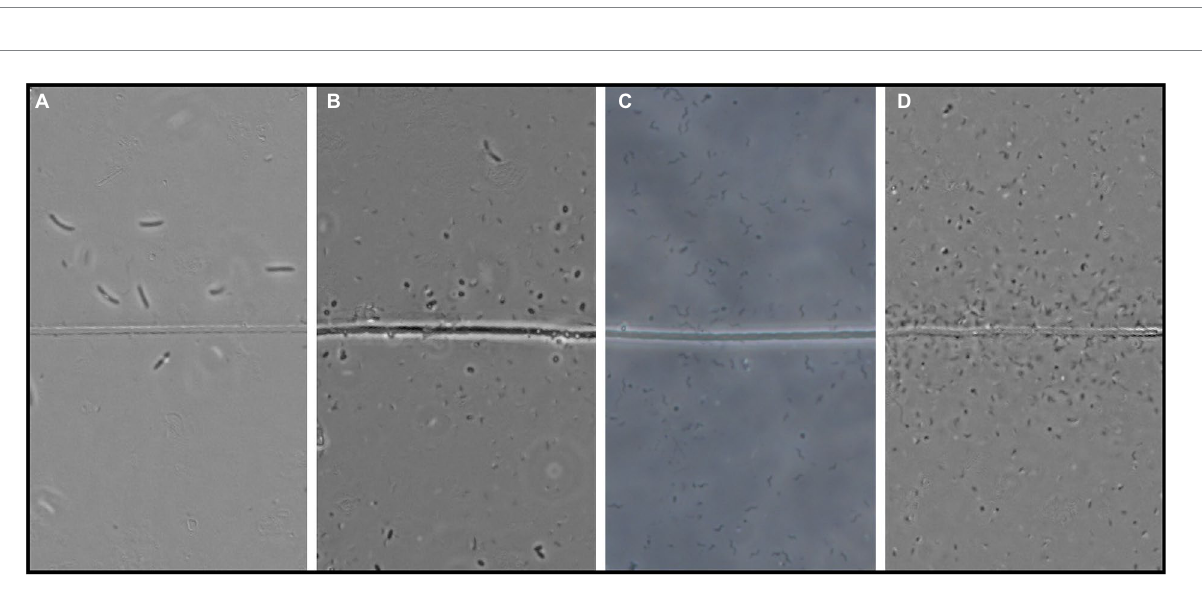
FIGURE 3 Four examples of the observed flocker morphologies. (A) Large curved rods, (B) Coccoids, (C) Spirillae, and (D) Vibrioids. “Line” in the middle is the cable bacteria filament. Scale bar, 5 μ